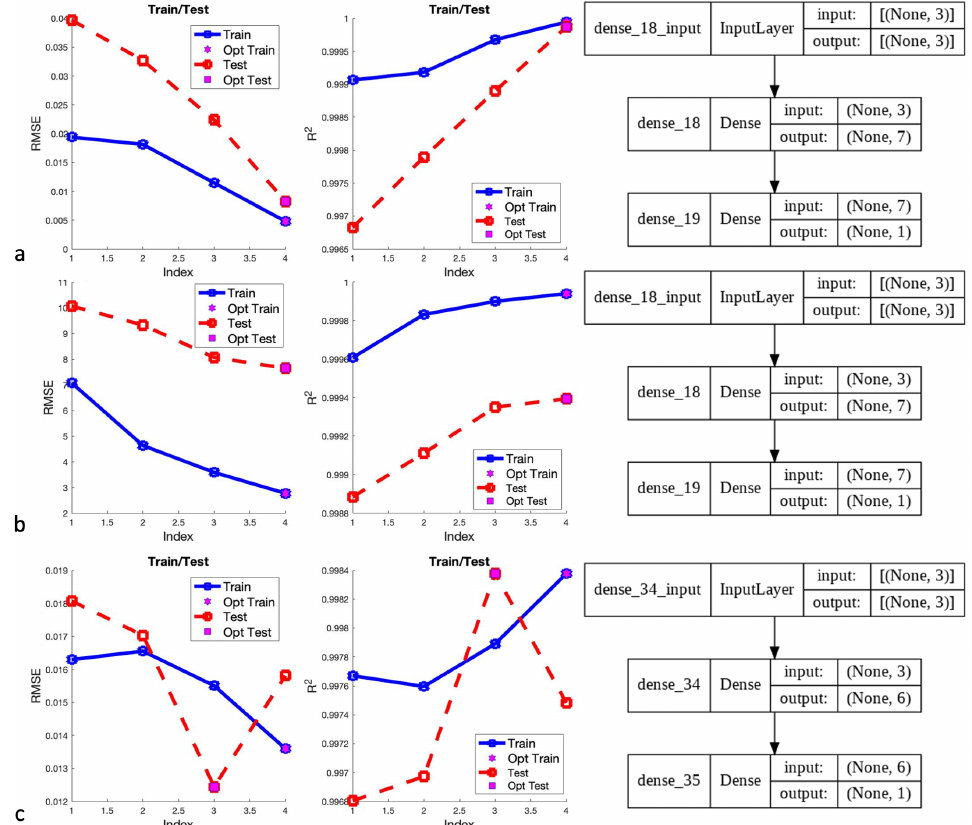
Figure 15. Different scenarios using ANN/SA for ( a ) B x , ( b ) B y , and ( c ) B z .